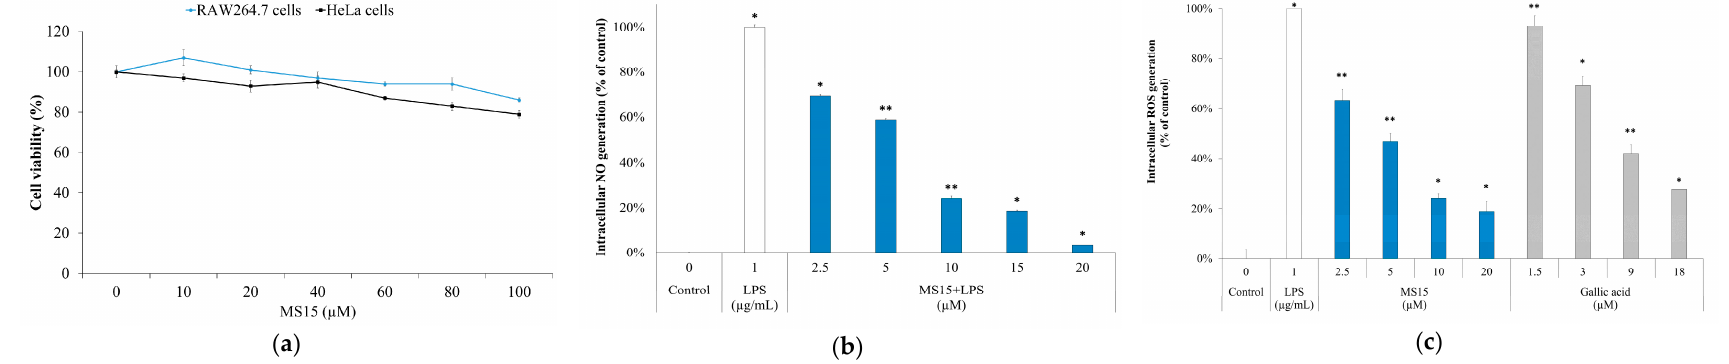
Figure 5 . ( a ) Cytotoxicity assay, cell seeding (RAW 264.7 cells, and HeLa cells) was performed into 96-well microplate at a density of 5.5 × 10 5 cells/well. ( b ) Generation of NO and ( c ) generation of ROS were evaluated in RAW 264.7 cells. Applying the student's t-test, a significant difference from the control denoted as, ** p < 0.01, * p ˂ 0.05.